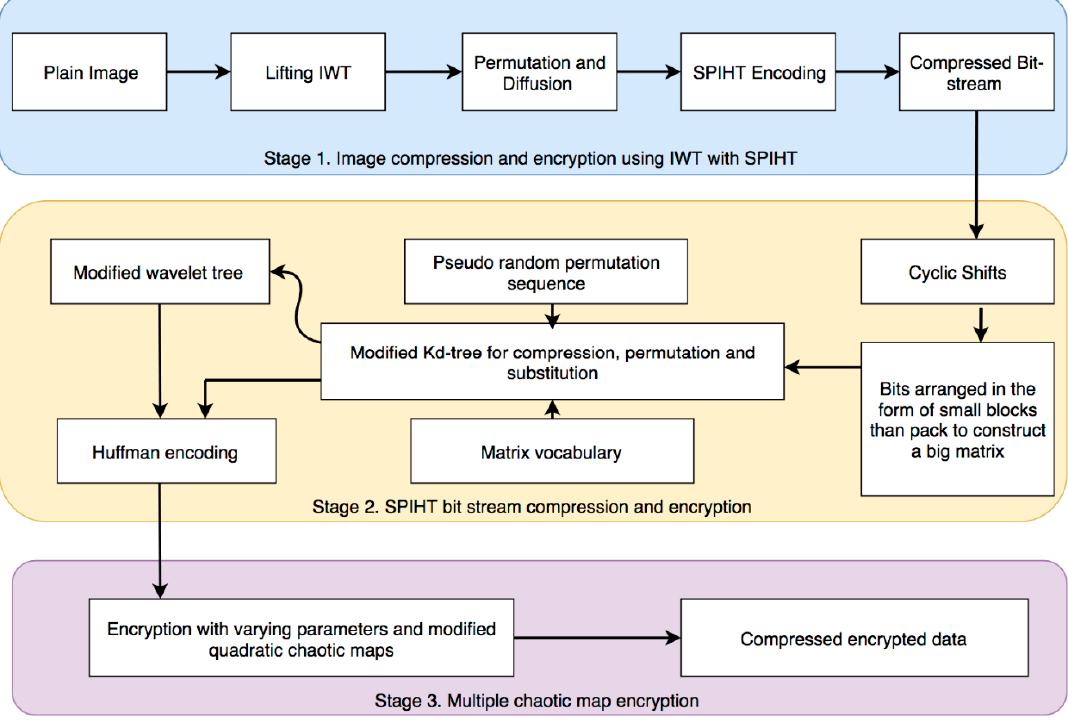
Figure 5. Joint image compression and encryption process.